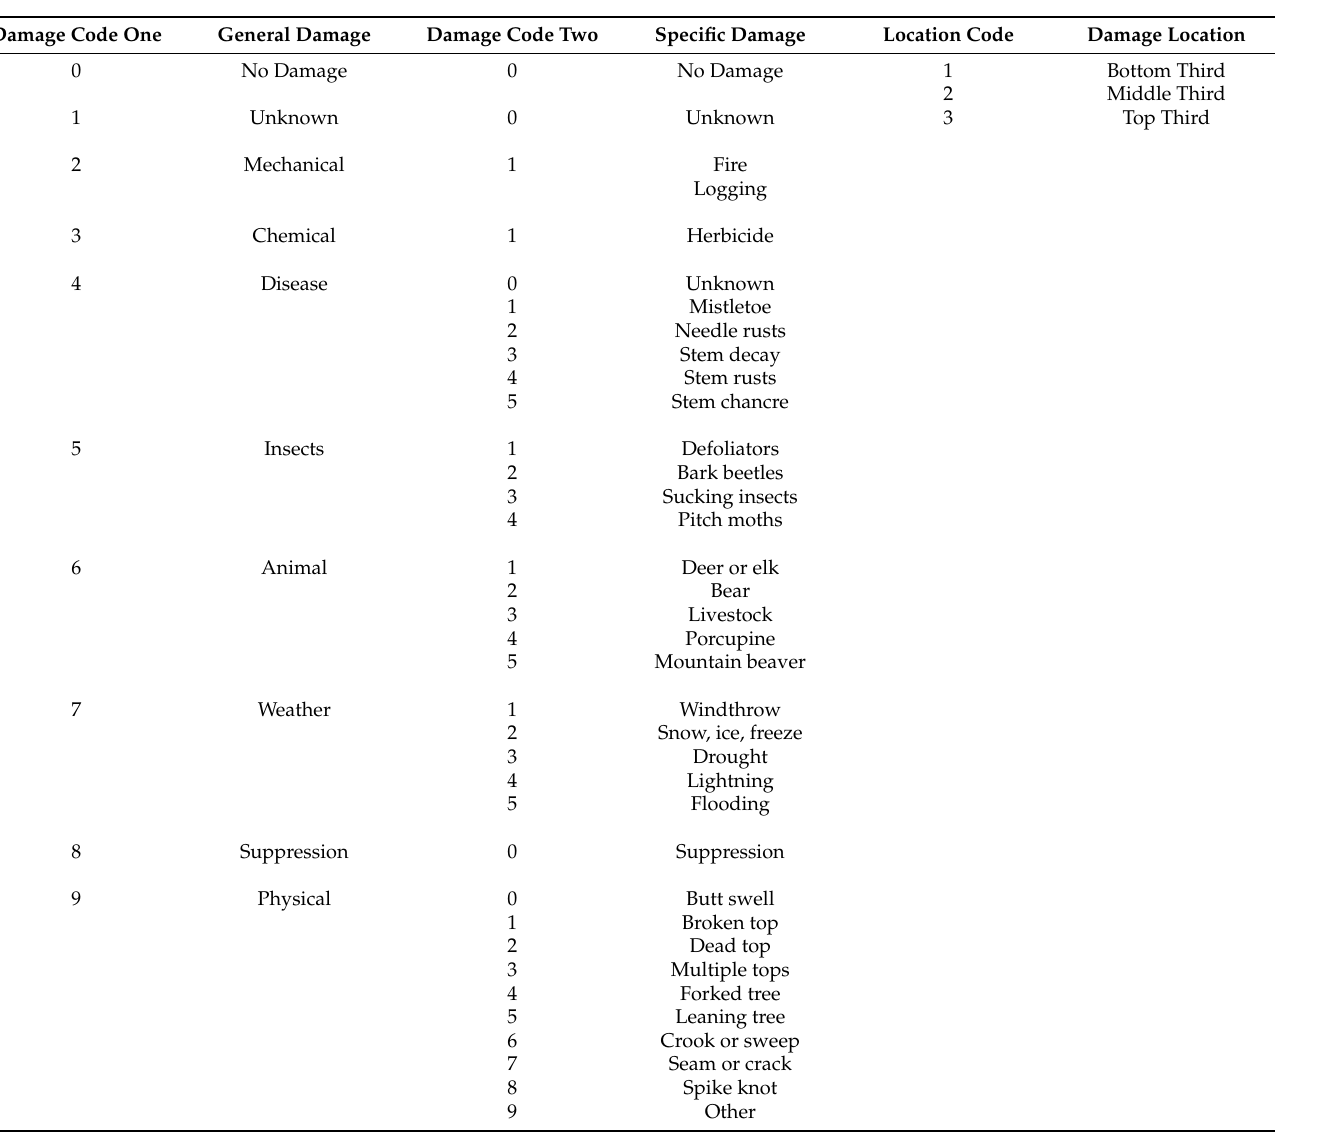
Table 1. Damage and location codes used in field data collection. Location codes refer to positions along the total height of the tree stem, divided into